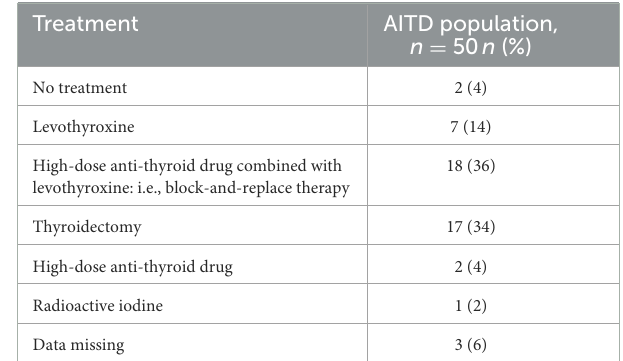
TABLE 3 Treatment for ALZ-induced